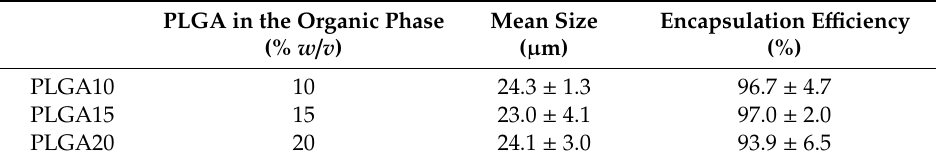
Table 1. Composition and main characteristics of the produced microspheres